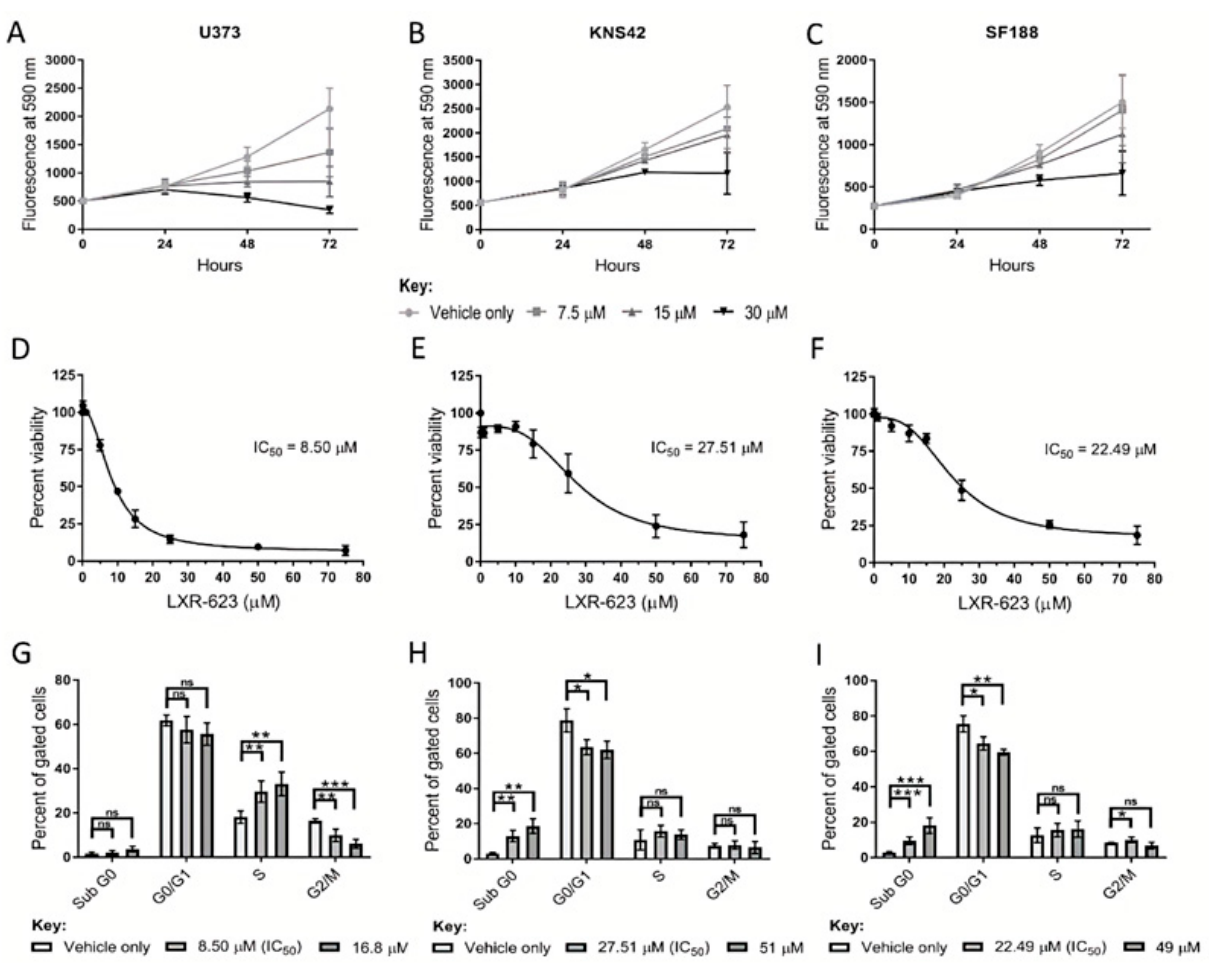
Figure 5. Therapeutic efficacy of the LXR agonist LXR-623 in diffuse cells. ( A – C ) Treatment of U373, KNS42, and SF188 cells with 7.5, 15, and 30 µM LXR-623 for 72 h, respectively. ( D – F ) Dose- response curves to determine IC 50 (half maximal inhibitory concentration) values of LXR-623 in U373, KNS42, and SF188 cells. ( G – I ) Flow cytometric cell cycle analysis following treatment with LXR-623 for 72 h at respective IC 50 concentrations and at higher concentrations deemed to result in 25% cellular viability. Results are the mean ± SEM ( A – F ) or SD ( G – I ) for n ≥ 3 independent replicates. Statistical evaluation of differences between the two culture conditions was conducted using t -tests: ns = not significant * p < 0.05; ** p < 0.01; *** p < 0.001; .